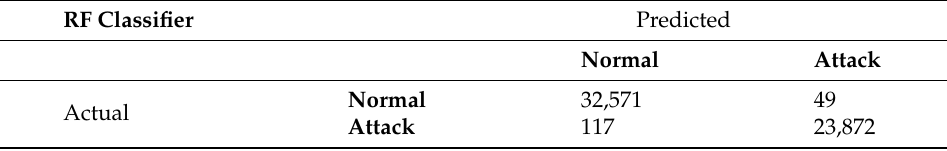
Table 5. Confusion matrix of Random Forest (RF) classifier test for malicious and normal traffic detection over IoT healthcare dataset generated using IoT-Flock